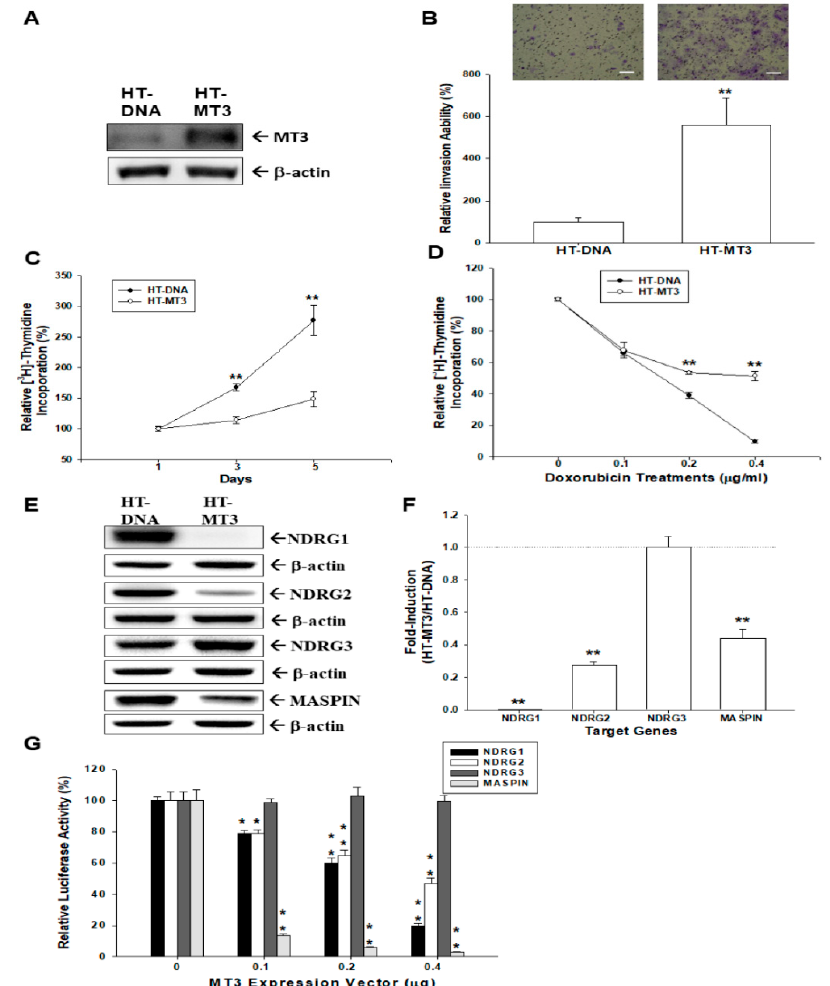
Figure 2. Effects of MT3 on proliferation, invasion, and expressions of NDRG1 , NDRG2 , NDRG3 ,